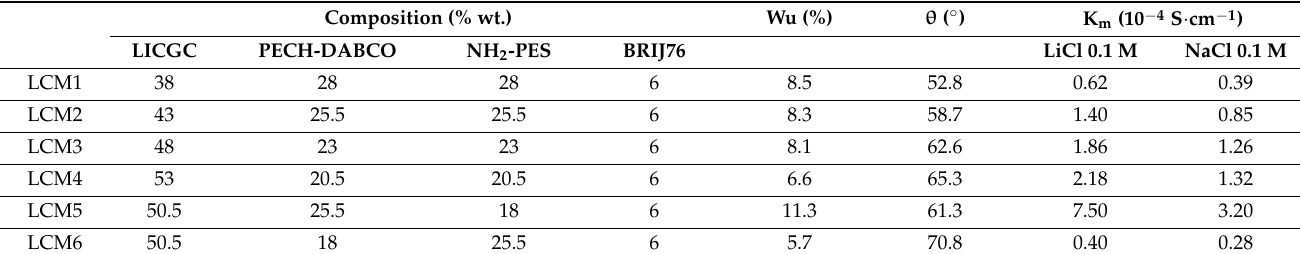
Table 1. Composition and characteristics of prepared membranes.